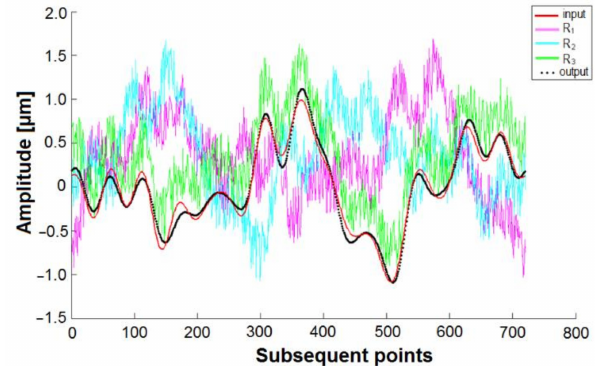
Figure 11. Example of the random error